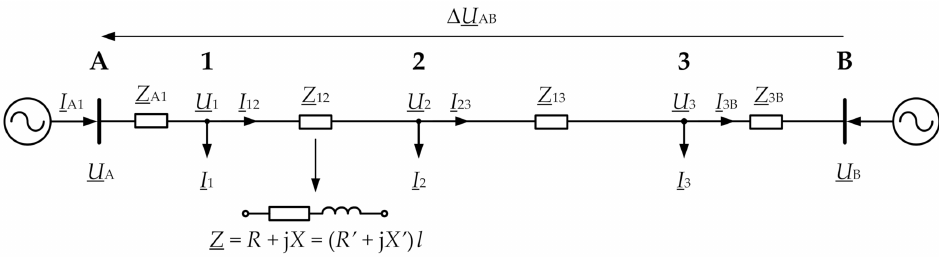
Figure A1. Diagram of a two-sided supplied